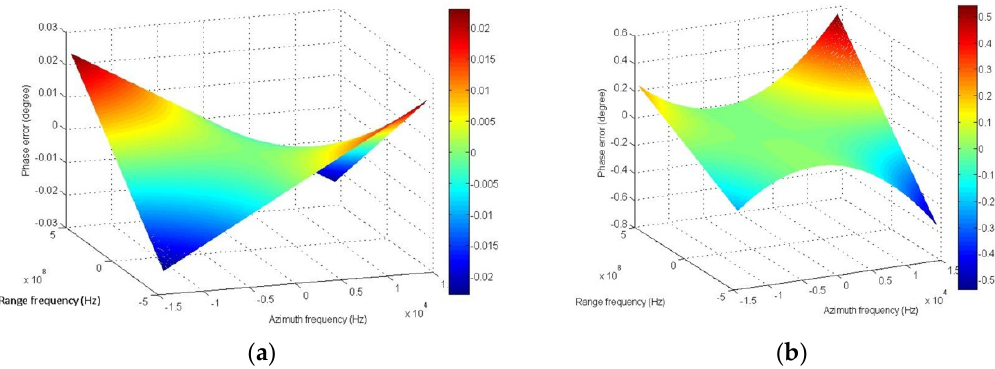
Figure 6. Phase errors induced by the time-scaling factor m k . The distribution of the residual phases in the two-dimensional frequency domain at the range edge ( a ) and the azimuth edge ( b ).